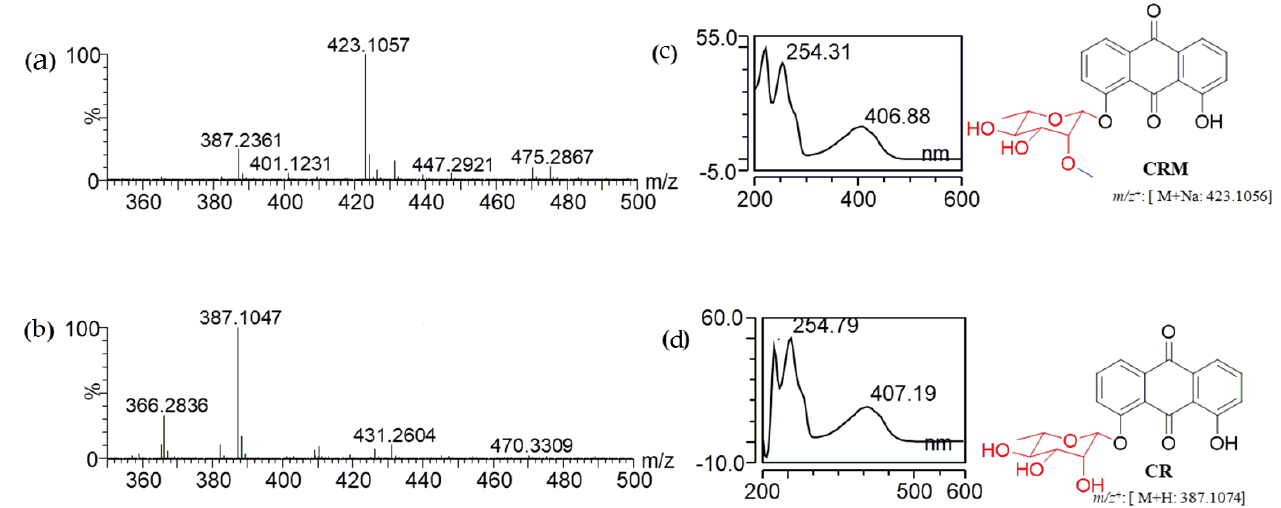
Figure 3. HR-QTOF ESI/MS chromatogram of ( a ) chrysazin-8- O - α -L- 2′ - O -methylrhamnoside ; ( b ) chrysazin-8- O - α - L -rhamnoside; ( c ) UV/VIS of CRM, ( d ) UV/VIS of